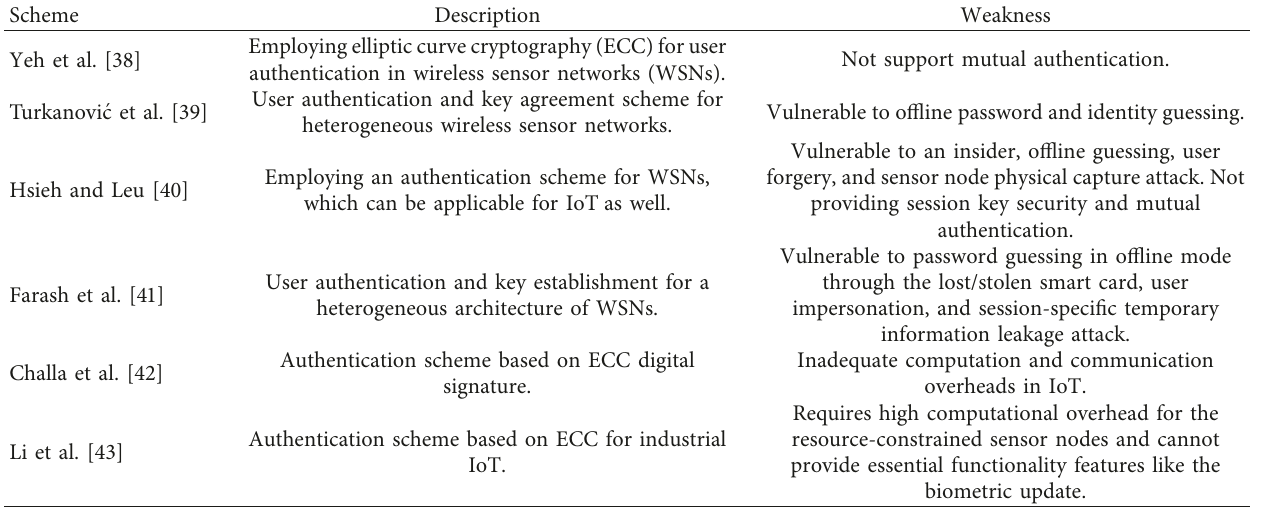
Table 3: Authentication schemes applicable for cloud-driven IoT-based big data